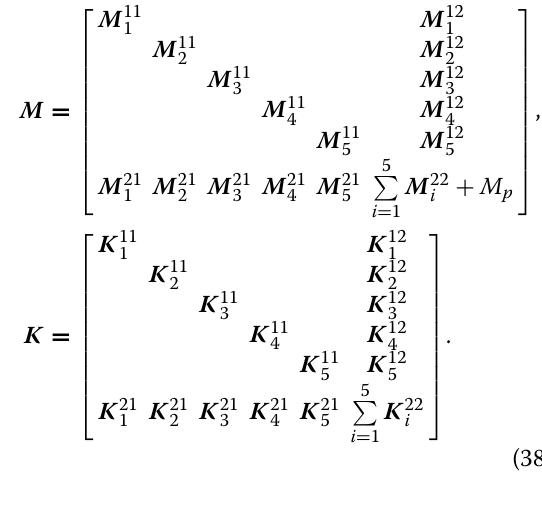
where U is the array of generalized coordinates of the 5-PSS/UPU parallel mechanism system. M and K are the mass matrix and rigidity matrix, respectively. C = (cid:31) 1 M + (cid:31) 2 K is the damping matrix of the system, (cid:31) (cid:31) and 1 and 2 are the Rayleigh damping coefficients. F ¨ U r is the array of the is the array of generalized forces. accelerations of rigid bodies, which can be obtained through the kinematic analysis of the rigid body of the 5-PSS/UPU parallel mechanism.